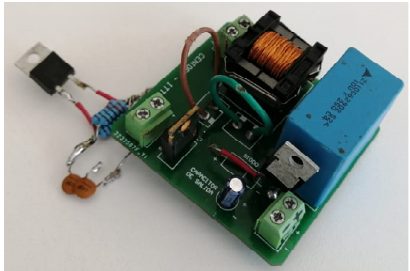
Figure 14. Prototype of the topology for experimental tests.